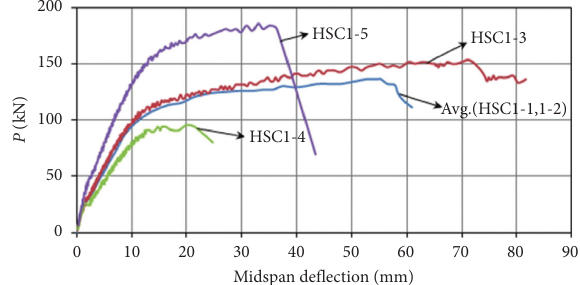
appeared.Cracks developed to the middle of the descriptionVertical cracks State